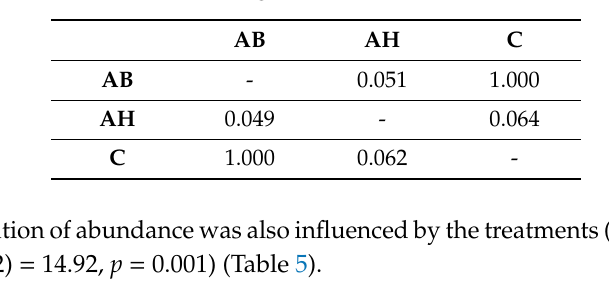
Table 4. Post hoc test for the multiple comparison of the percent prevalence variations calculated in the treatment groups. The Bonferroni-corrected p -values referring to the 16S rRNA and Hsp70 methods are shown respectively above and below the diagonal.